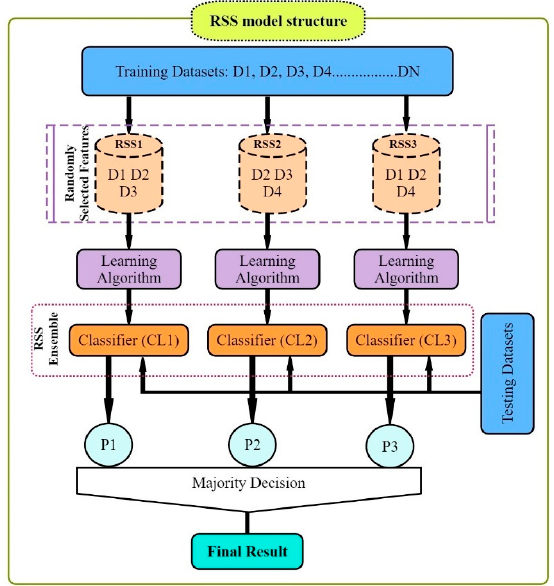
Figure 5. The block diagram of random subspace.